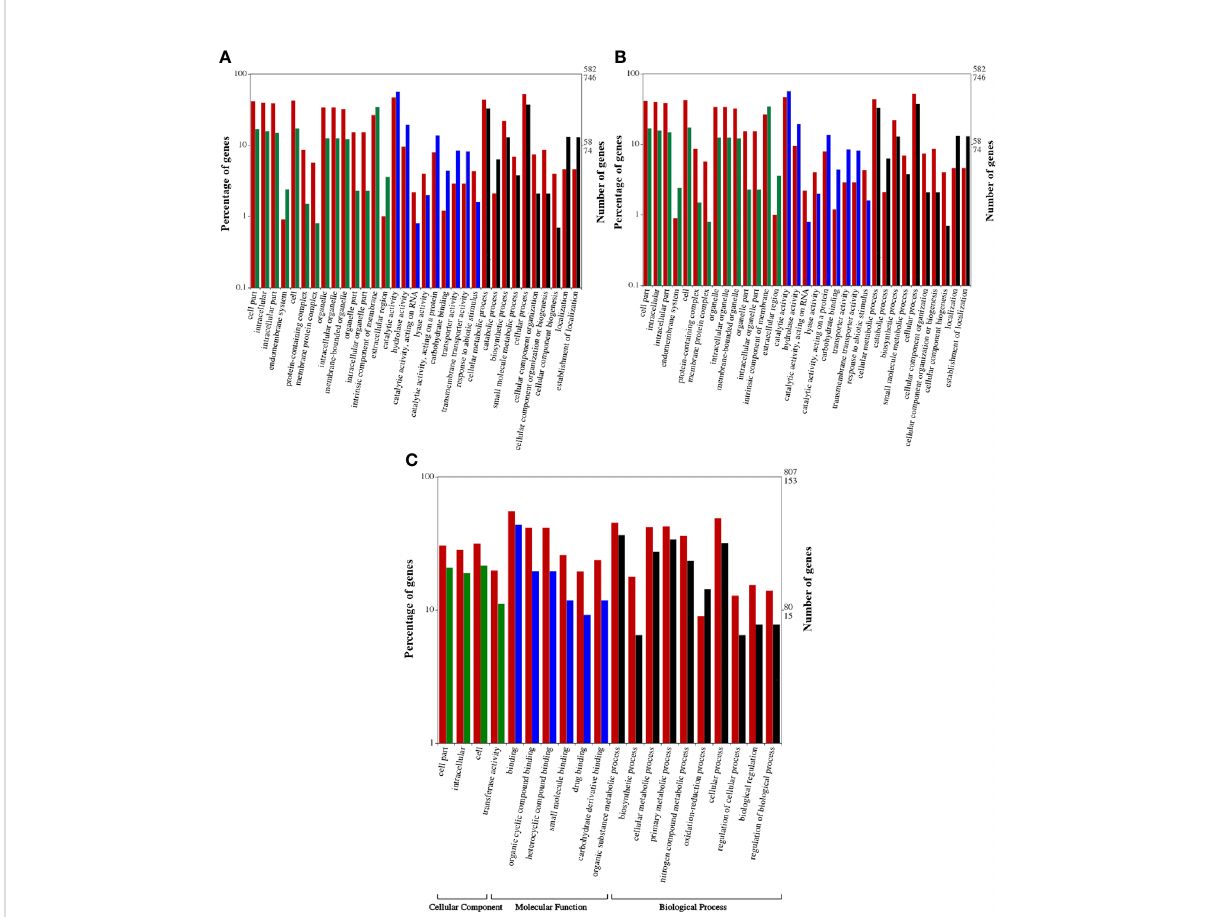
FIGURE 3 (A) Gene ontological analysis of tolerant aestivum wheat genotype, HD2967 uninfested leaf in comparison to HD2967 infested leaf after 48 h of R. maidis feeding. Red bars indicate downregulated genes whereas green, blue and black bars indicate upregulated genes of cellular, molecular and biological processes, respectively. (B) Gene ontological analysis of susceptible durum wheat genotype, A -9-30-1 uninfested leaf in comparison to A-9-30-1 infested leaf after 48 h of R. maidis feeding. Red bars indicate downregulated genes whereas green, blue and black bars indicate upregulated genes of cellular, molecular and biological processes, respectively. (C) Gene ontological analysis of tolerant aestivum wheat genotype, HD2967 infested leaf in comparison to susceptible durum wheat genotype, A -9-30-1 infested leaf after 48 h of R. maidis feeding. Red bars indicate downregulated genes whereas green, blue and black bars indicate upregulated genes of cellular, molecular and biological processes,